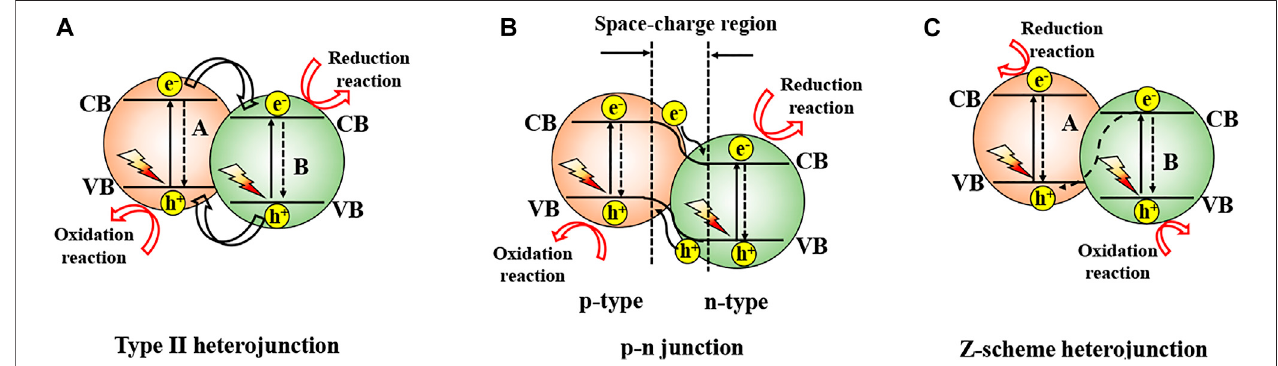
FIGURE 5 | (A) Type II photocatalysts; (B) p-n junction; and (C) Z-scheme strategy for higher photocatalytic